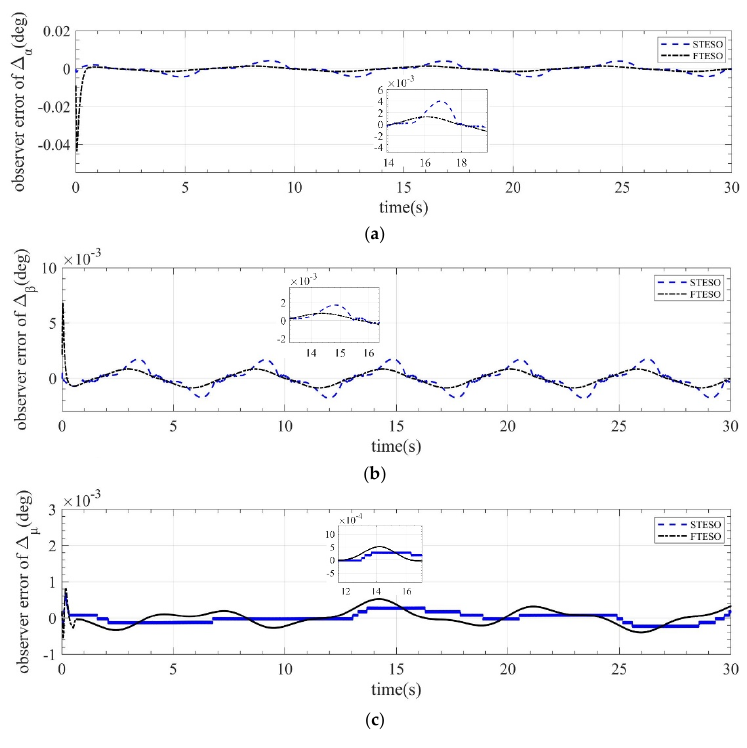
∼  Δ ∆ α , ( b ) observer error curve of α , ( b ) observer error curve of (the value of Δ μ estimated by the STESO have μ